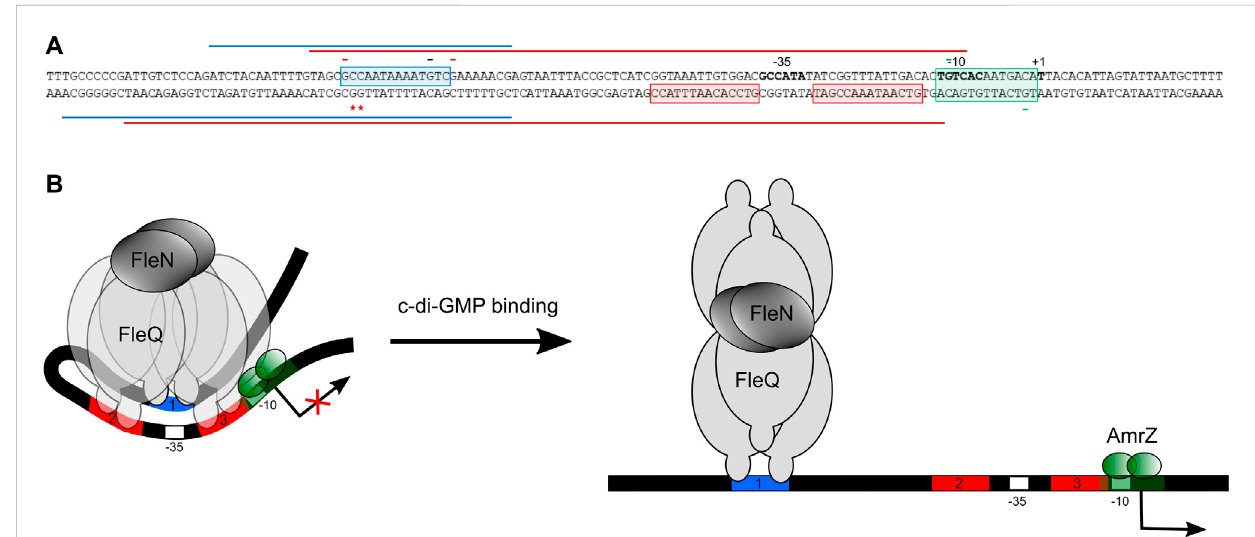
FIGURE 8 Molecular model of FleQ/FleN-mediated wss transcription. (A) Summary of in vitro and in silico results regarding the binding of FleQ, FleN, AmrZ at the wss promoterintheabsence(redline)andinthepresence(blueline)ofc-di-GMP.The-10and-35regionsandthe wss transcriptionalstartsitearein bold. *, indicates DMS hyperreactivity and -, DMS protection. The red colour shows that the protection or reactivity is detected in the absence of c-di- GMP, the black that the protection takes place both in the absence and in the presence of c-di-GMP, and the green colour indicates that the protection is due to the presence of AmrZ. (B) . The diagram depicts a model incorporating our in vitro and functional data, and considering previous structural and functional information regarding FleQ from P. aeruginosa (Matsuyama et al.,